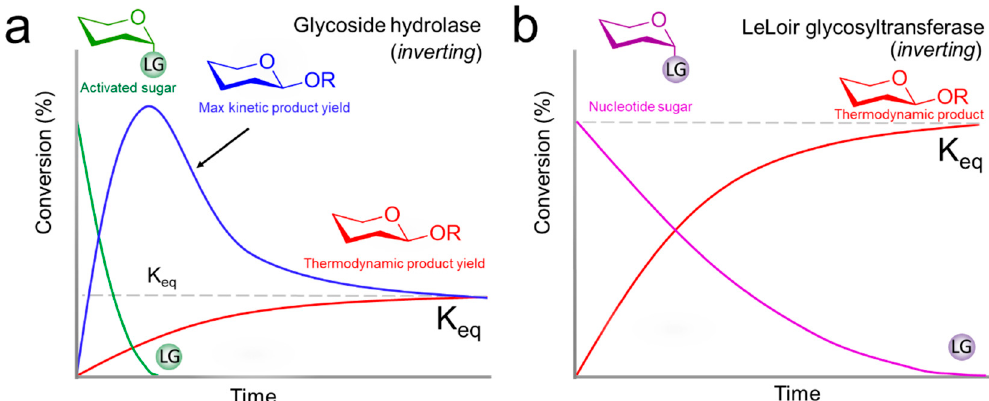
Figure 5. Exemplary enzymatic glycosylation of an activated sugar donor (green) and acceptor (R-group) to afford a maximum transient kinetic (blue) product yield catalyzed by a glycoside hydrolase, followed by reverse hydrolysis towards the thermodynamic product concentration. Direct esterification leads to the thermodynamic product yield K eq without the requirement for an activated sugar (red) in ( a ). LeLoir GTs only catalyze the direct esterification of a nucleotide sugar donor (purple) to thermodynamic product (red) in ( b ).